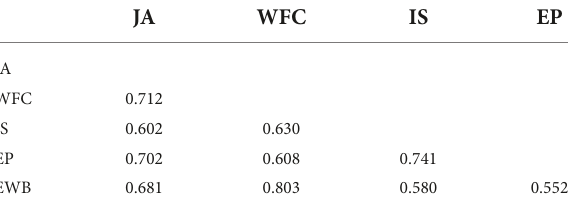
TABLE 2 Heterotrait-Monotrait ratio